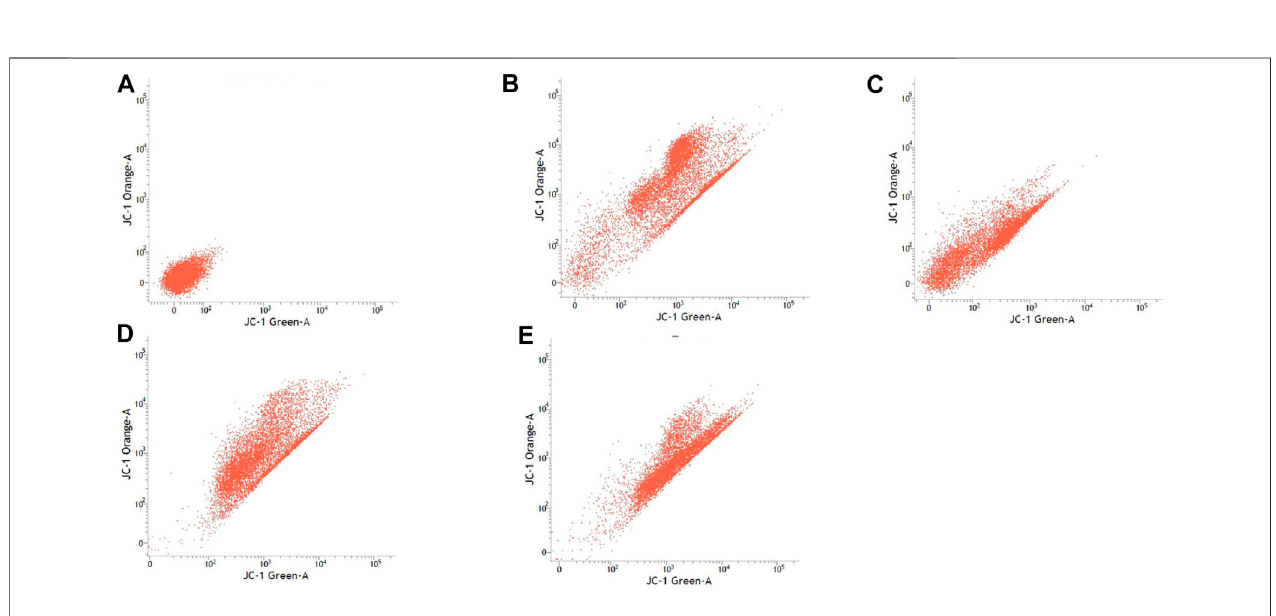
Frontiers in Pharmacology |